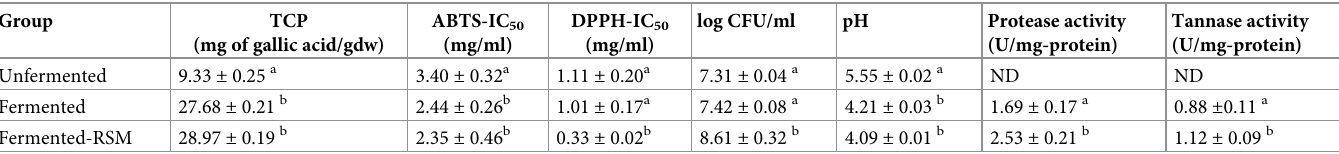
Table 4. Changes in TPC, cell number, pH, and DPPH and ABTS radical scavenging activity in djulis fermented with L . plantarum BCRC 11697.